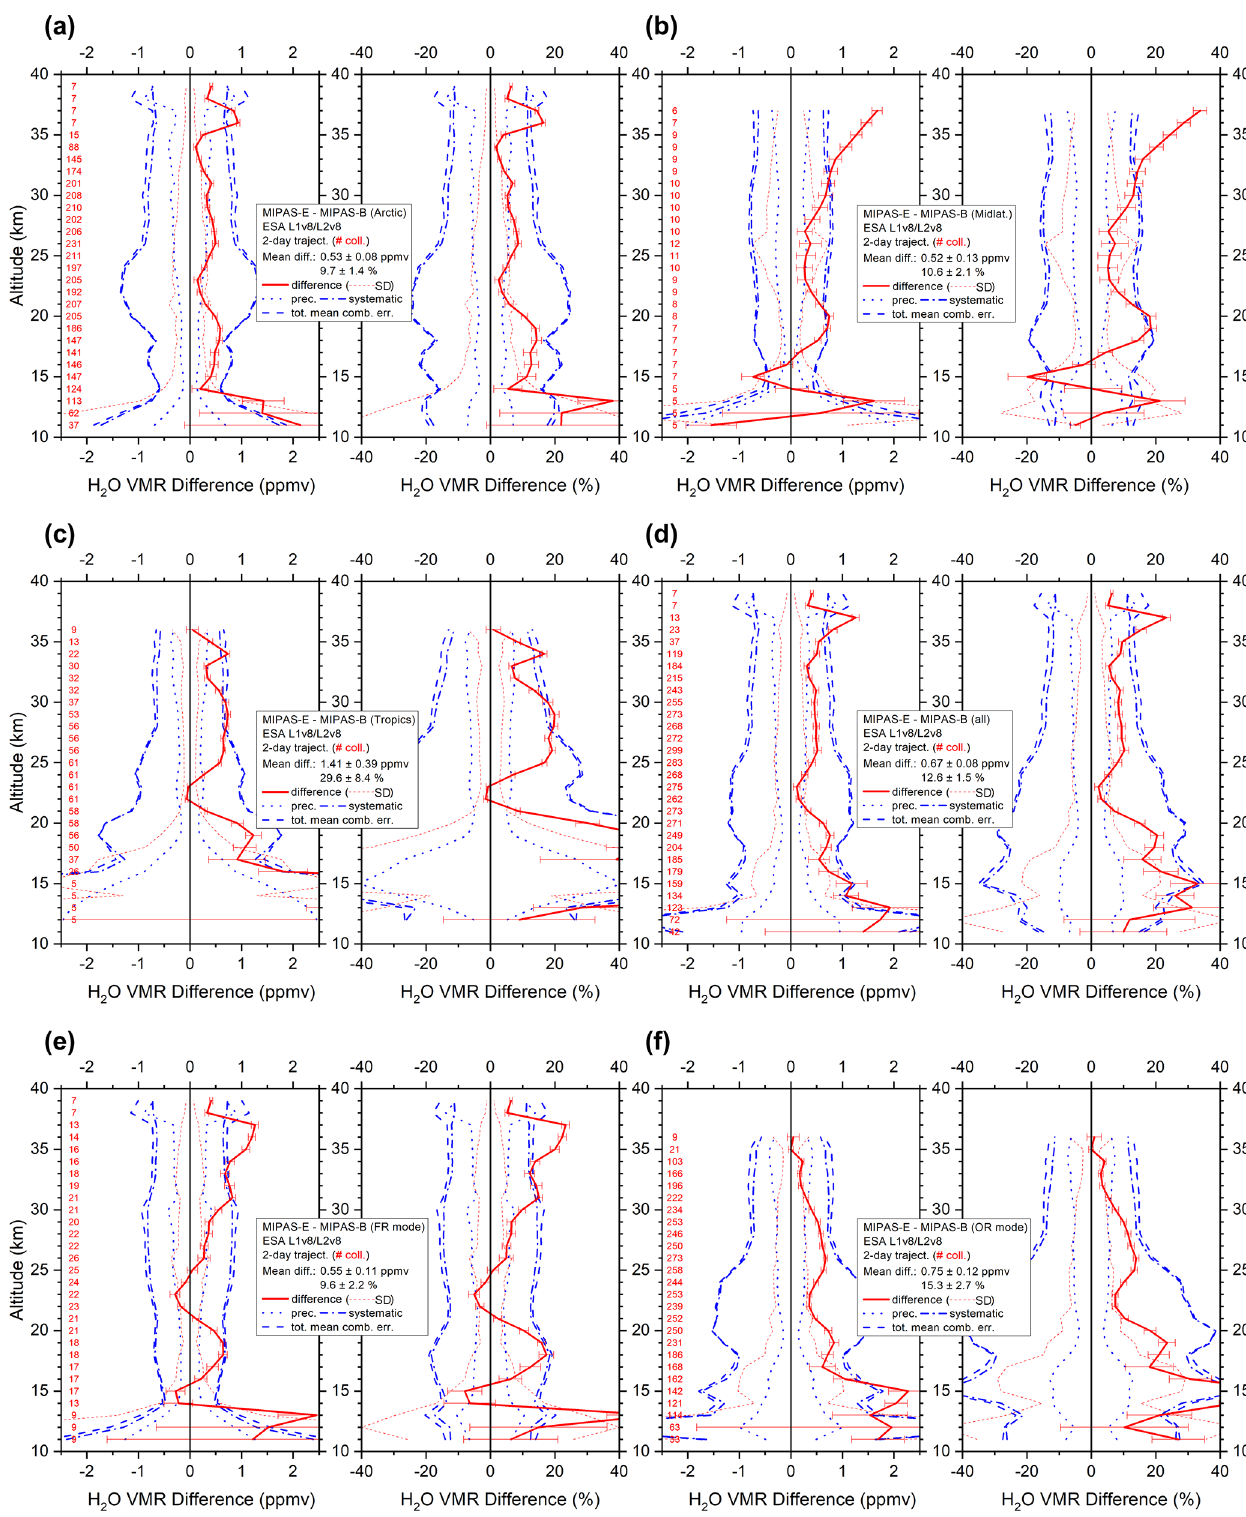
Figure 3. Mean absolute and relative H 2 O VMR differences of all trajectory match collocations (red numbers) between MIPAS-E and MIPAS-B (red solid line), including standard deviation (red dotted lines) and standard error of the mean (plotted as error bars). Precision (blue dotted lines), systematic (blue dash-dotted lines), and total (blue dashed lines) mean combined errors are shown too. Arctic (a) , midlatitude (b) , tropics (c) , all FR plus OR (d) , FR mode (e) , and OR mode (f) collocations. For details, see text. https://doi.org/10.5194/amt-15-6669-2022 Atmos. Meas. Tech., 15, 6669–6704,